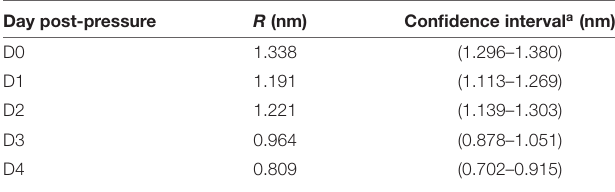
TABLE 4 | Estimated pore radius for the cluster with the lowest slope ( Figure 4